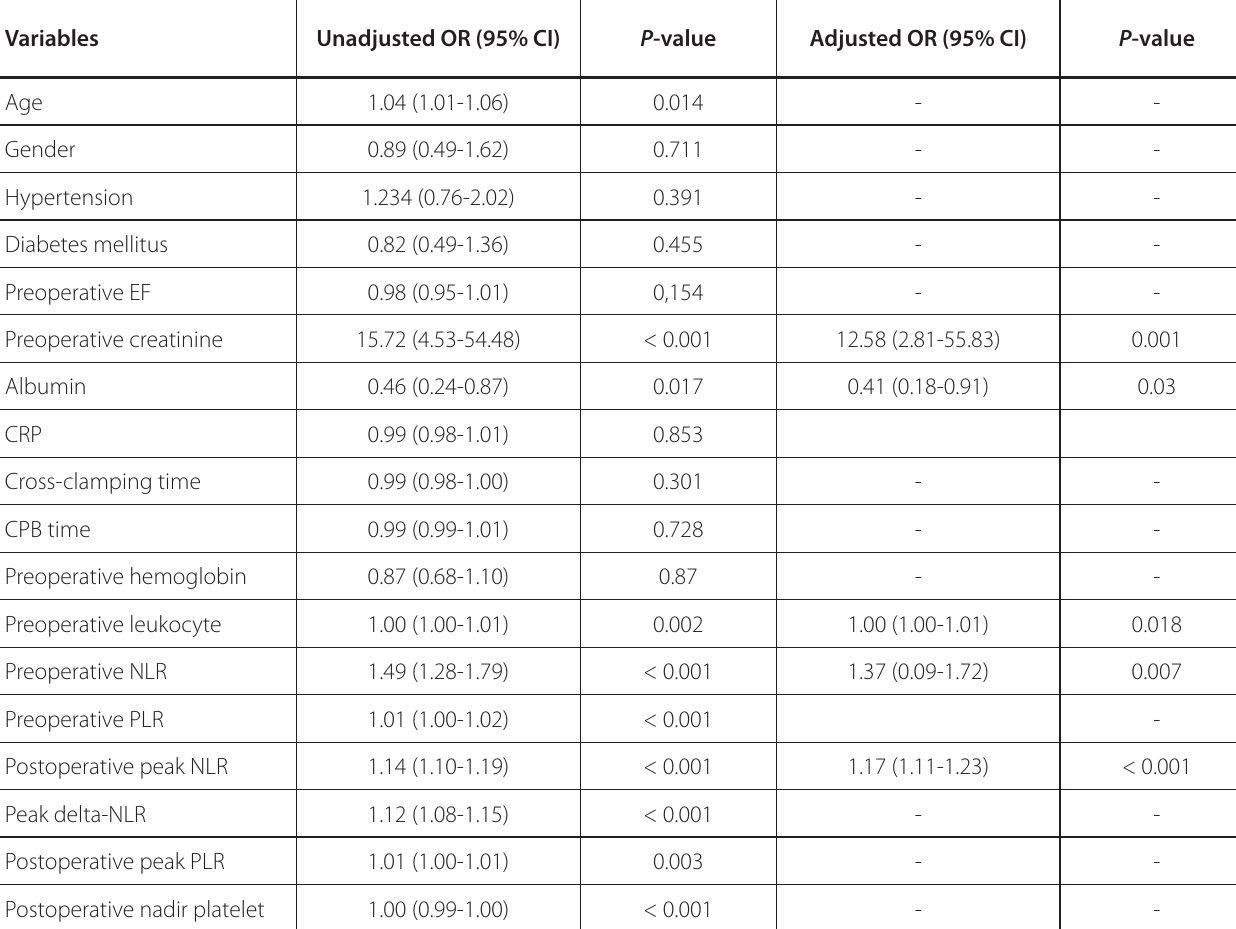
Table 4 . Univariate and multivariate regression analyses of risk factors for postoperative